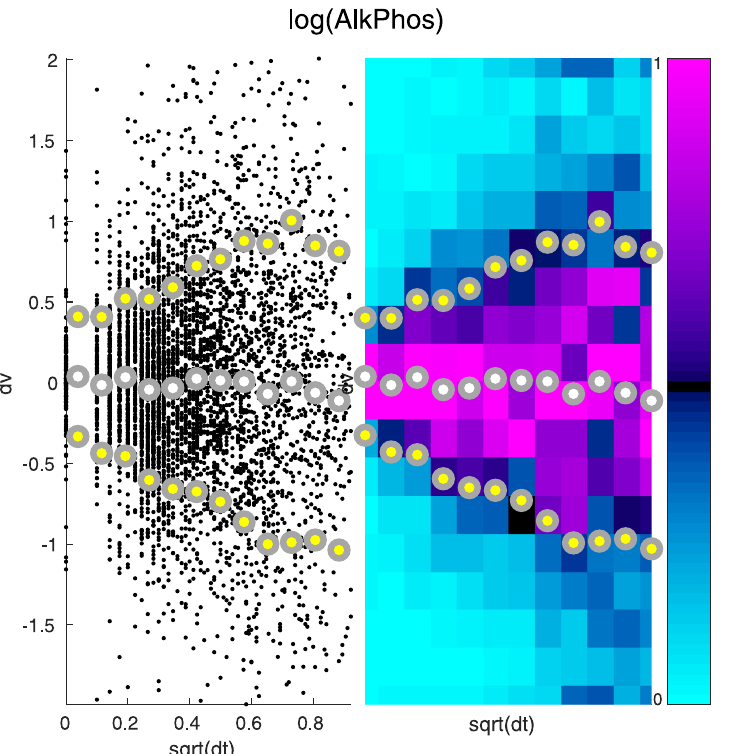
Fig 1. Increments of Alkaline Phosphatase. Here we illustrate the distribution of increments associated with Alkaline Phosphatase (AlkPhos). On the left we show a scatterplot of these increments. Each small black point in the background represents a pair of time-adjacent measurements in a single dolphin, with the square-root of the time- increment (in years) along the horizontal, and the change in AlkPhos along the vertical. The time-increments are then divided into 12 bins, and the mean (white dot) plus and minus one standard-deviation (yellow dots) are displayed in the foreground. On the right we show the same data, with the 12 time-bins shown as vertical strips. Each vertical strip is further divided into 18 boxes, which are colored by the number of increments within that time-bin which fall into that box (i.e., a histogram for each time-bin, scaled to have maximum 1, colored as shown in the colorbar to the far right). Note that the distribution of increments for each time-bin becomes wider as the time-increment increases. Importantly, the standard-deviation increases roughly linearly with the square-root of the time-increment (i.e., the variance increases roughly linearly with the time-increment), as expected from a Brownian-process. Note also that the variance is nonzero even when the time-increment is 0, implying that there must be an extra source of variation in addition to this